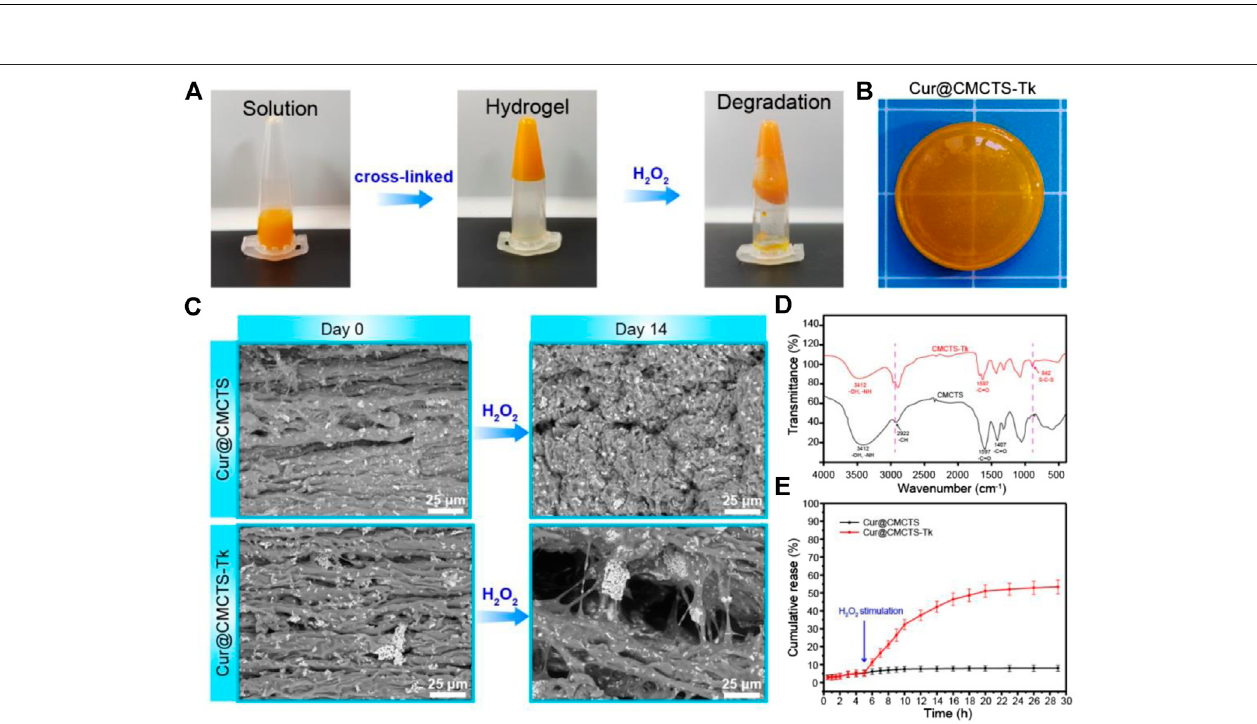
FIGURE 2 | (A) Sol − gel transition behavior of Cur@CMCTS-Tk hydrogel. (B) Image of Cur@CMCTS-Tk hydrogel for burn wound repair. (C) SEM image of Cur@ CMCTSand